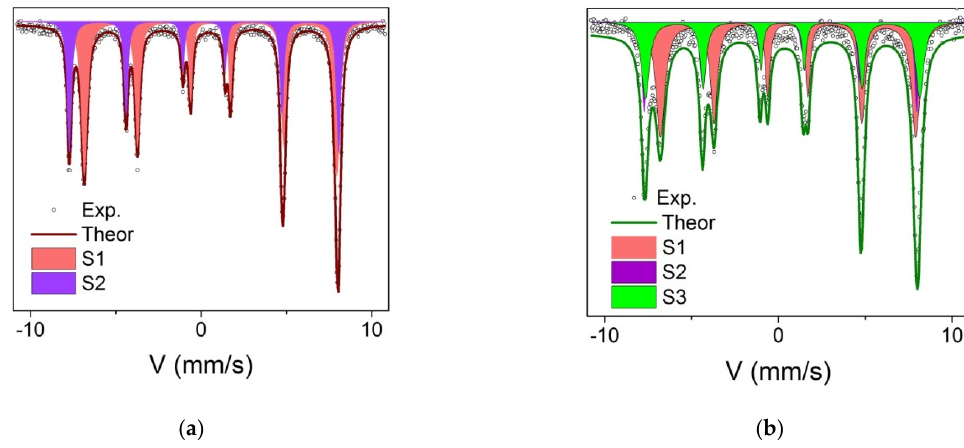
Figure 8. Mössbauer spectra of Fe 3 O 4 @C ( a ) and Fe 3 O 4 @C@C ( b ) samples measured at 300 K. Table 1. Mössbauer parameters of the samples Fe 3 O 4 @C and Fe 3 O 4 @C@C at room temperature. IS